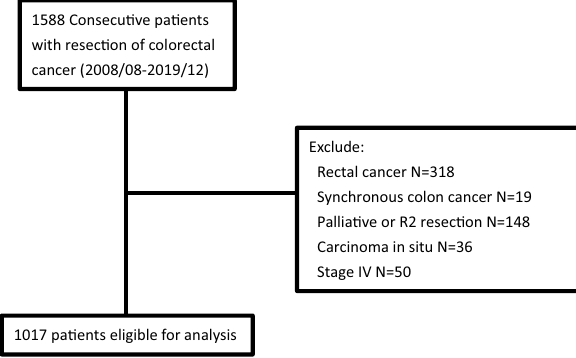
Figure 1. Flow diagram of colorectal cancer patients included in the